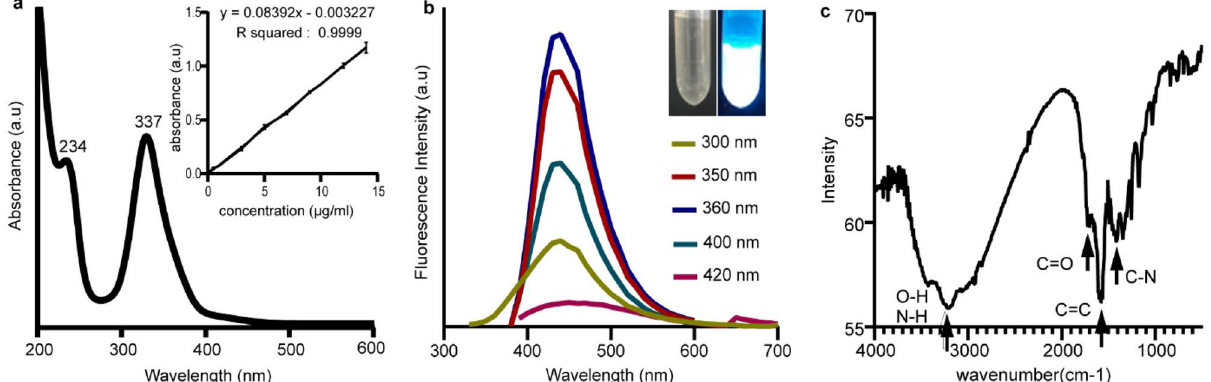
Figure 3. ( a ) UV–Vis absorption spectrum of synthesized GQDs (Inset shows the standard curve drawn based on serial dilution results). ( b ) Photoluminescence spectra of GQDs under different excitation wavelengths of 300–420 nm. The insets are optical images of the solution of GQDs taken under visible light (left) and excited by 360 nm UV light (right). ( c ) FTIR spectrum of GQDs, arrows on the spectrum indicate characteristic bands of functional groups of